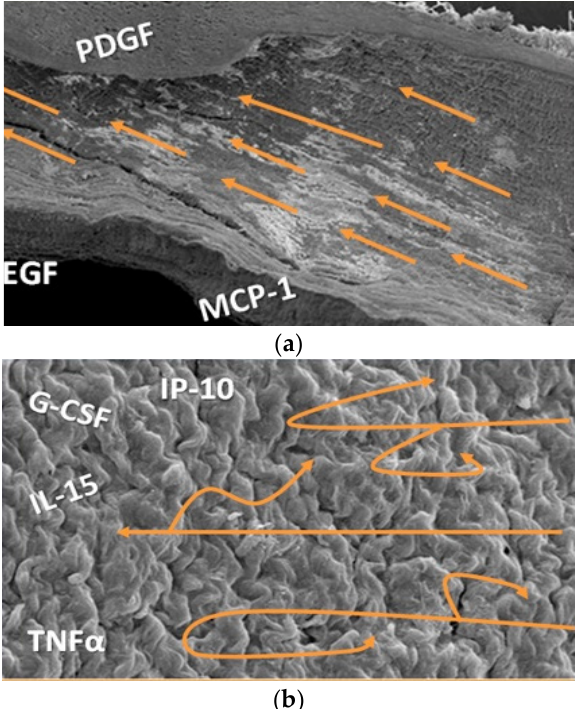
Figure 1. Scanning electronic microscopy of the lumen of human veins. On the top ( a ) regular disposition of the endothelial cells in accordance with direction of the laminar flow regimen. Bottom ( b ): irregular arrangement of the endothelial cells in response to a turbulent and oscillatory flow regimen. The labels refer to the different endothelial expression of cytokines respectively induced by laminar flow, top, and by turbulent and oscillatory flow regimen, Bottom. This Special Issue contains innovative articles describing physics markers linked to blood flow haemodynamics and to oxygenation and fluids distribution in the tissues.